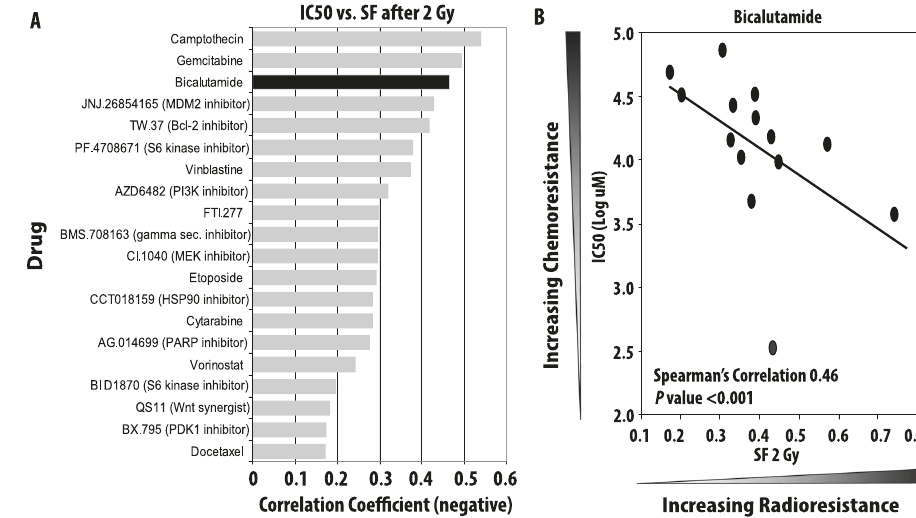
Fig. 1 A novel radiosensitizer screen nominates AR-inhibition as one of the most effective strategies in treating radioresistant BCC lines. Clonogenic survival assays were performed to determine the intrinsic RT sensitivity of 21 BCC lines (0 – 8 Gy RT) with signi fi cant heterogeneity in intrinsic radiosensitivity of the BC cell lines. IC50 values were determined for 130 clinically available compounds and correlation coef fi cients were calculated using IC50 values (for drug sensitivity) and surviving fraction after 2 Gy of radiation (SF-2Gy for radiation sensitivity). Bicalutamide was identi fi ed as one of the most effective drugs for treatment of radiation-resistant breast cancers ( a ) with a correlation coef fi cient of 0.46 ( b